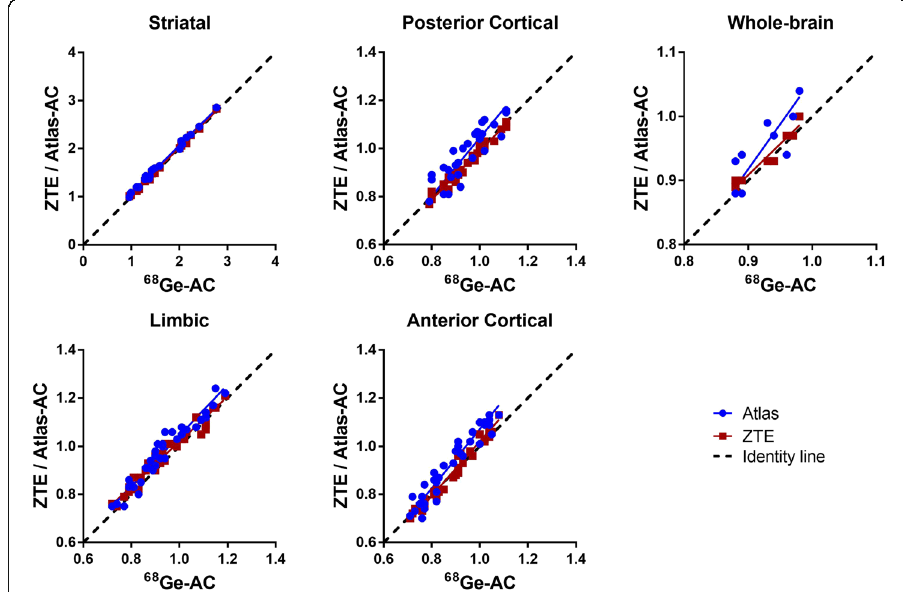
Fig. 6 Relationship between SUVR for different brain regions when using 68 Ge-attenuation correction (AC; gold standard) and ZTE-or atlas-AC. Solid lines represent Deming regressions, and the dashed lines represent